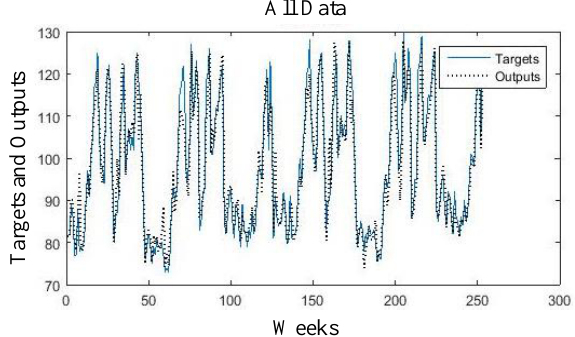
Fig. 11. Comparison of targets and outputs for MLPNN model.